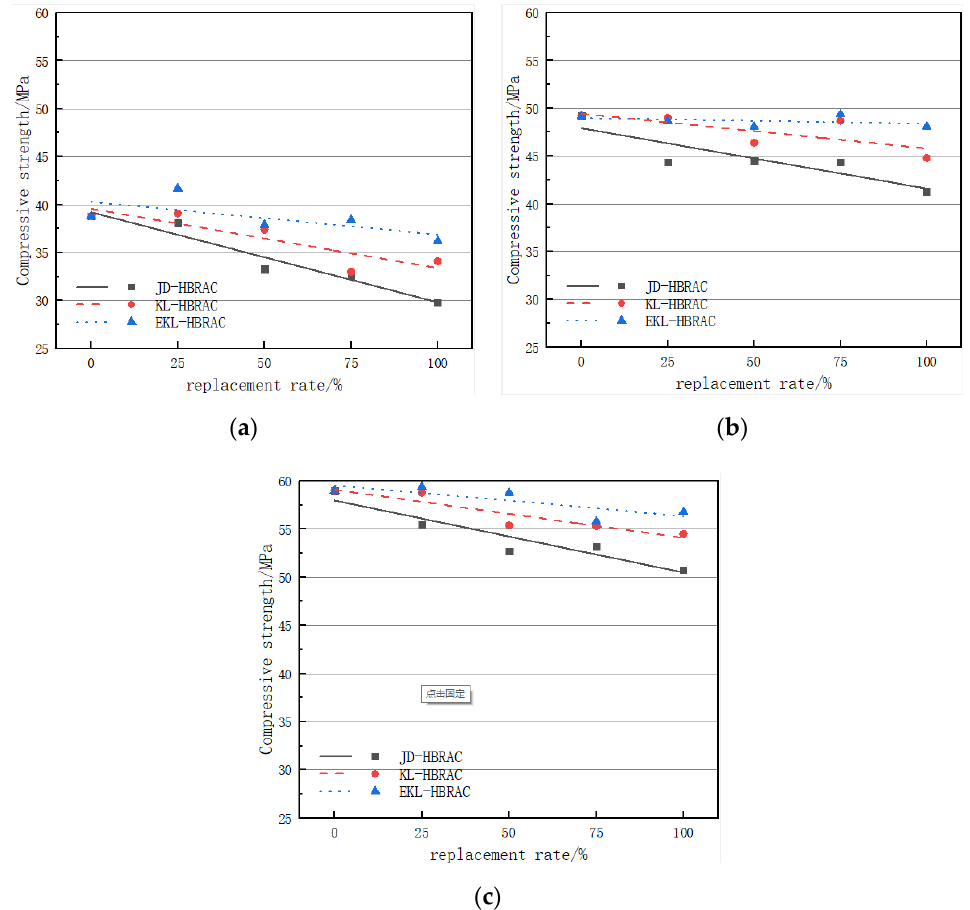
Figure 4. Effect of RCA quality and the replacement ratio on compressive strength of HBRAC: ( a ) cementitious material content 300 kg/m 3 , ( b ) cementitious material content 400 kg/m 3 , and ( c ) cementitious material content 500 kg/m 3